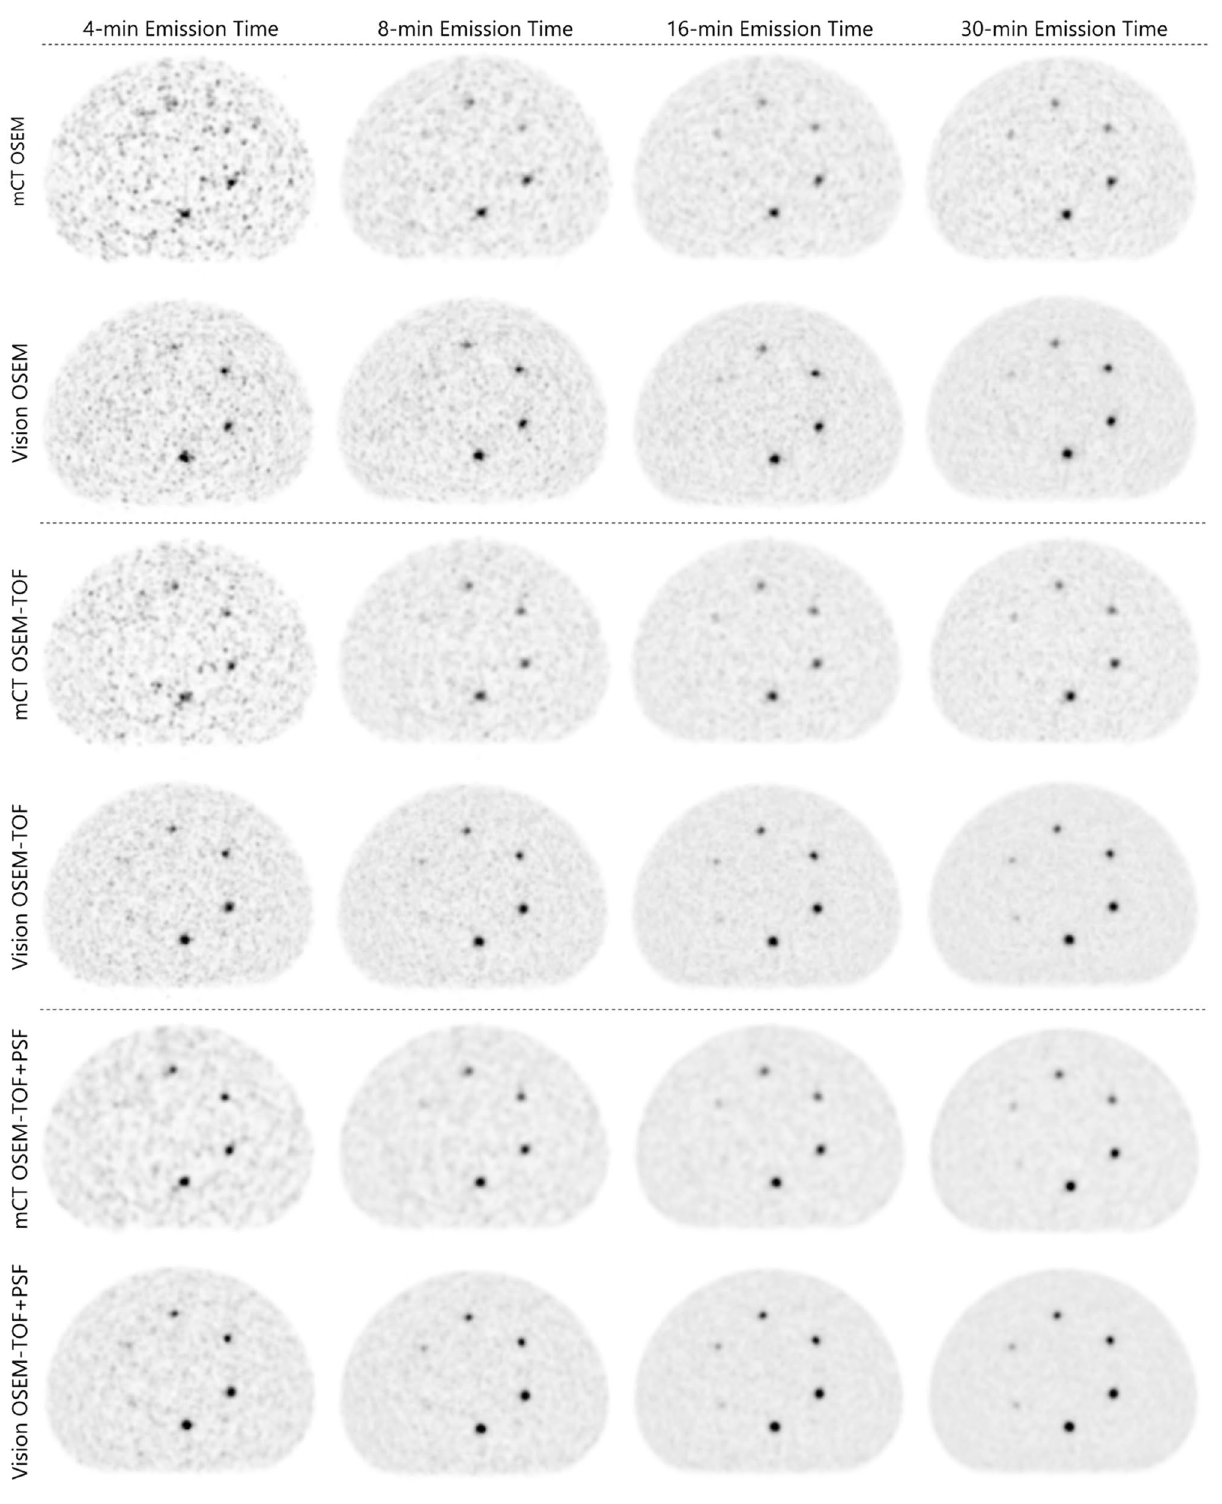
Figure 2. Evaluated PET images at the first imaging time point (sphere activity concentration ~ 25 kBq/ml). The position of the small spheres inside the phantom is presented in Fig. 1). Sphere diameters are depicted in Fig.